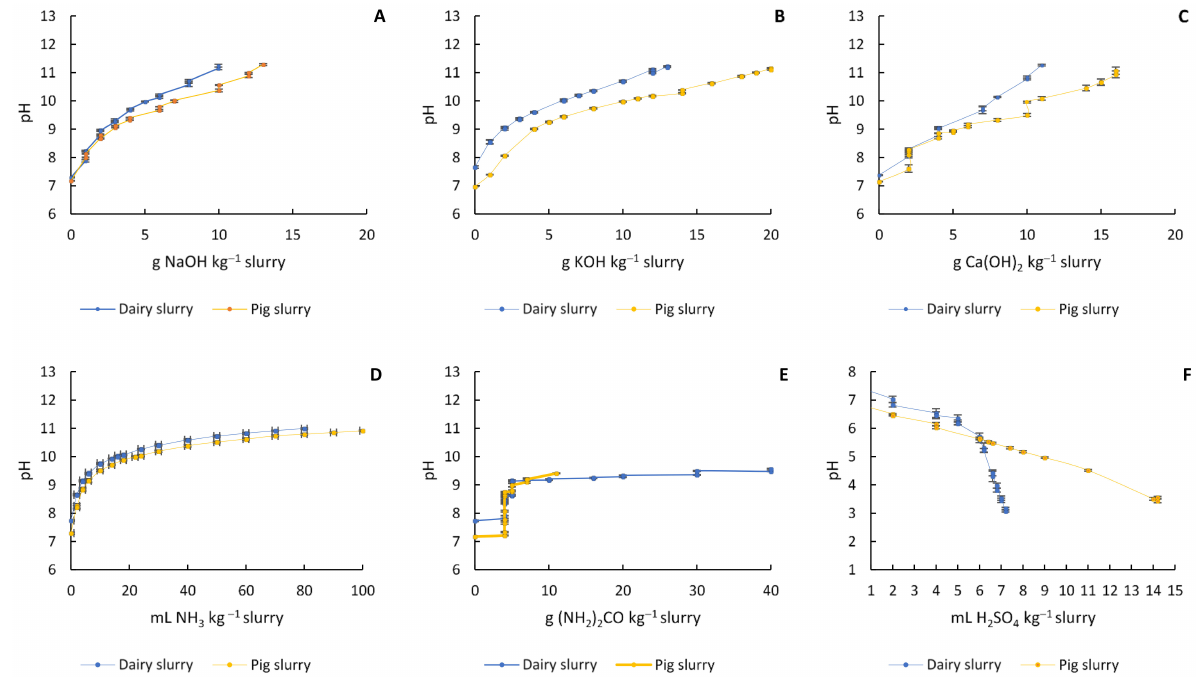
Figure 1. Titration curves for dairy and pig slurries (DS or PS) alkalinized with sodium hydroxide ( A ), potassium hydroxide ( B ), calcium hydroxide ( C ), ammonia ( D ) and urea ( E ), and titration curves for dairy and pig slurries acidified with sulfuric acid ( F